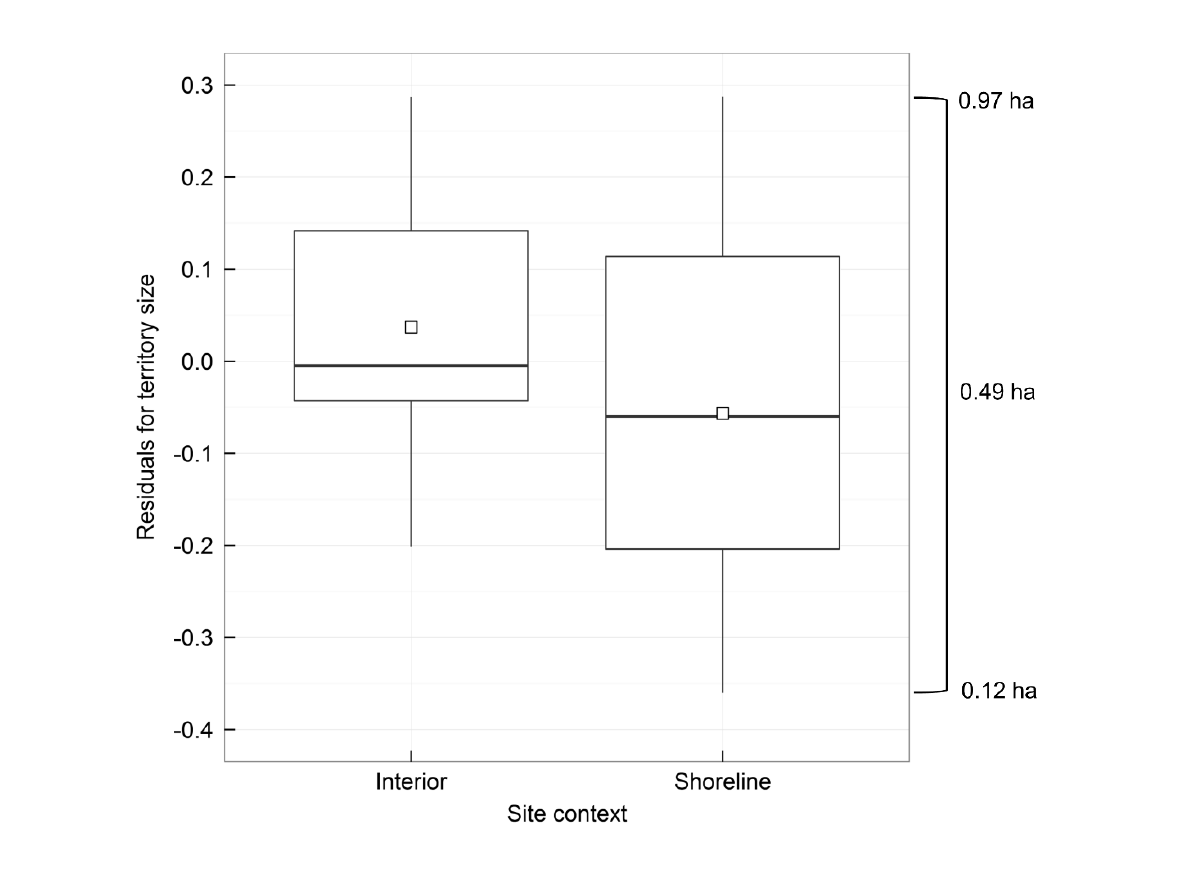
Figure A1.1. Partial residual boxplot illustrating relationship between site context and territory size. The solid black horizontal line in each box represents the median and the square in each box represents the mean. The area above and below the horizontal line represents the 50th to the 75th and the 25th to the 50th percentiles, respectively. The vertical lines or whiskers extend to the highest and lowest values contained within 1.5 times the interquartile range of the data. The bracket on the right, from top to bottom, illustrates the maximum, median, and minimum measurements for territory size (ha; 50% KDE contour),